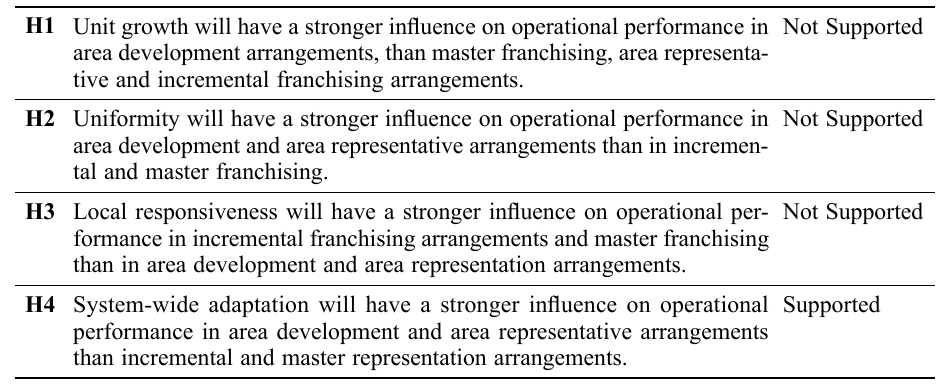
Table 5. Overview of hypotheses